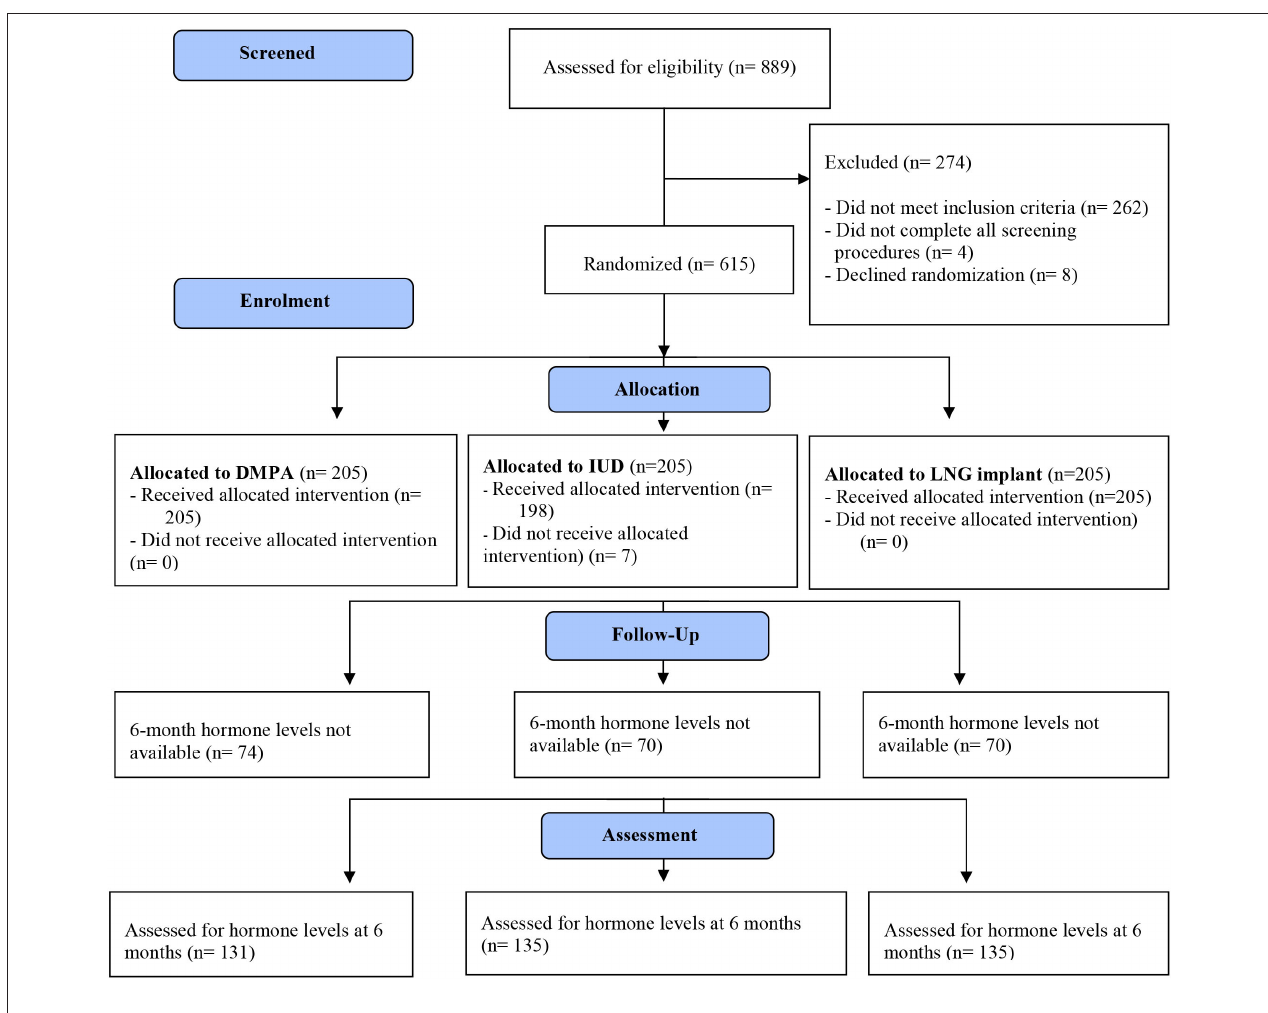
FIGURE 1 | CONSORT flow